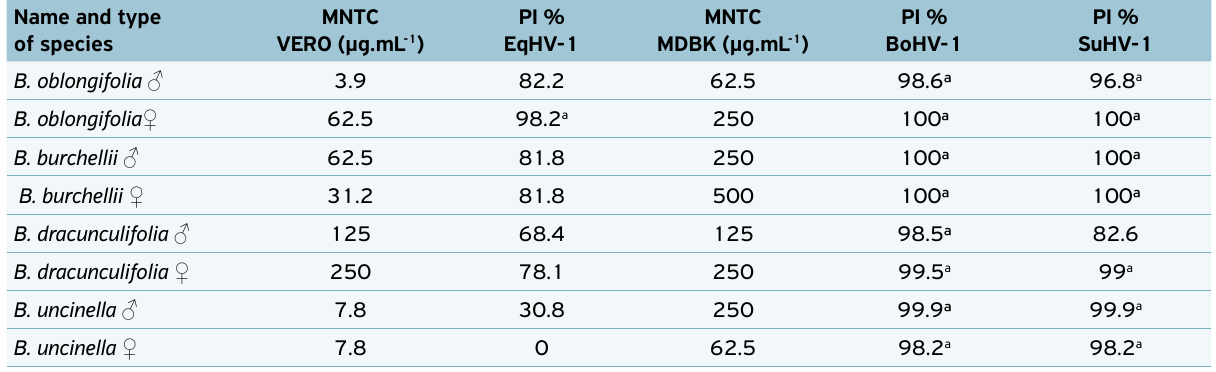
Table 3. Maximim non‑toxic concentration (MNTC) of the species of Baccharis tested in MDBK and Vero cell lines; the percentage of inhibition (PI) against equine (EqHV‑1), swine (SuHV‑1) and bovine (BoHV‑1) herpesviruses. Name and type of